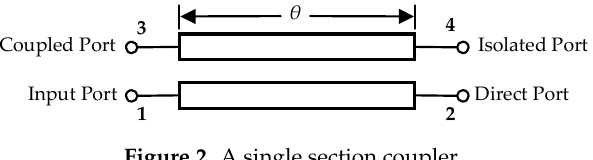
Figure 2. A single section coupler.